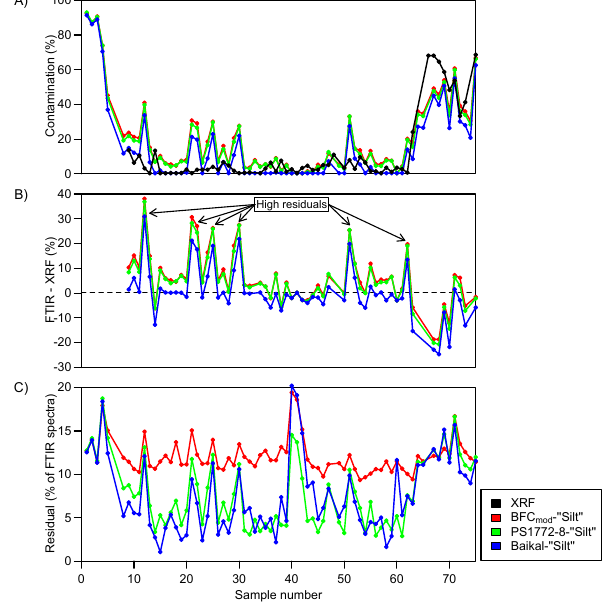
Fig. 5. FTIR two end-member results: (A) FTIR and XRF esti- mates of contamination in Lake Baikal samples; (B) FTIR minus XRF estimates of contamination. Positive/negative values indicate FTIR over/under-estimation of sample contamination; (C) Residu- als ( Residual c ) from the fitting of the sample FTIR spectra against the best-fit modelled FTIR spectra. No XRF results for some sam- ples indicates the absence of sufficient material for XRF